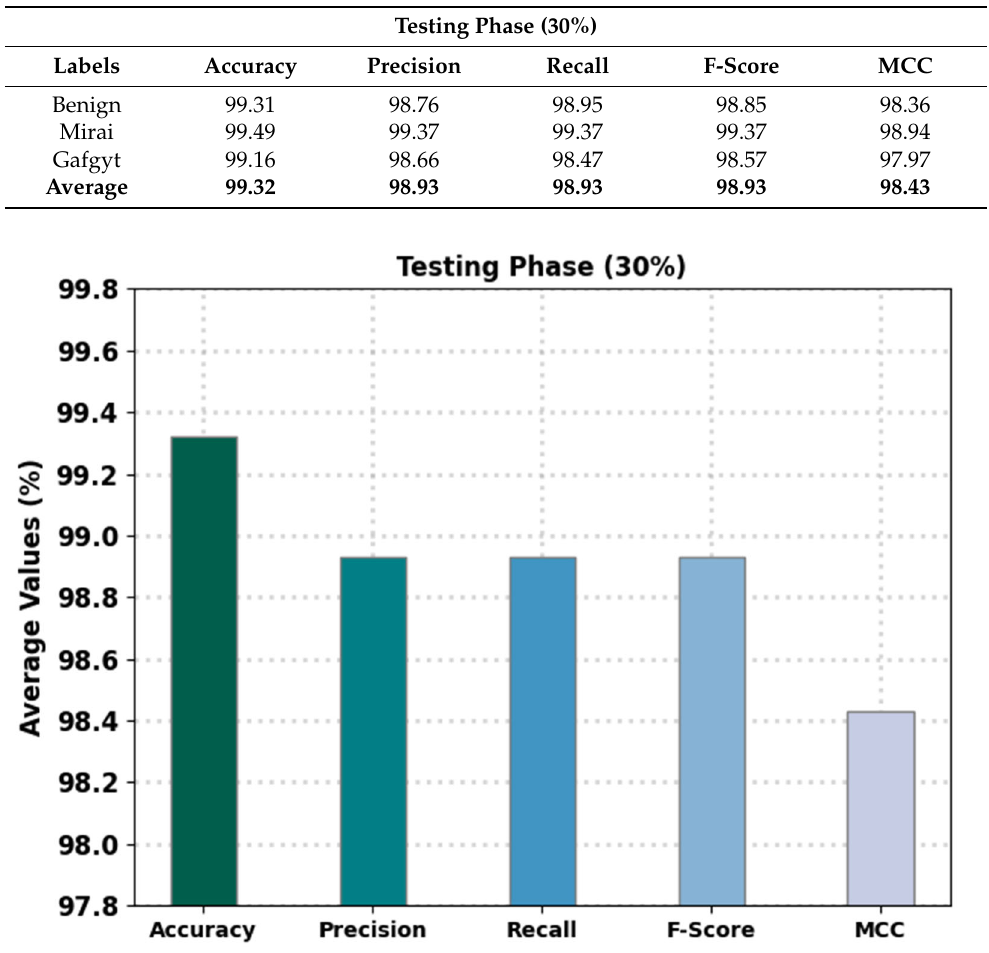
Figure 7. TRA and VLA analysis for BND ‐ BMOML algorithm.